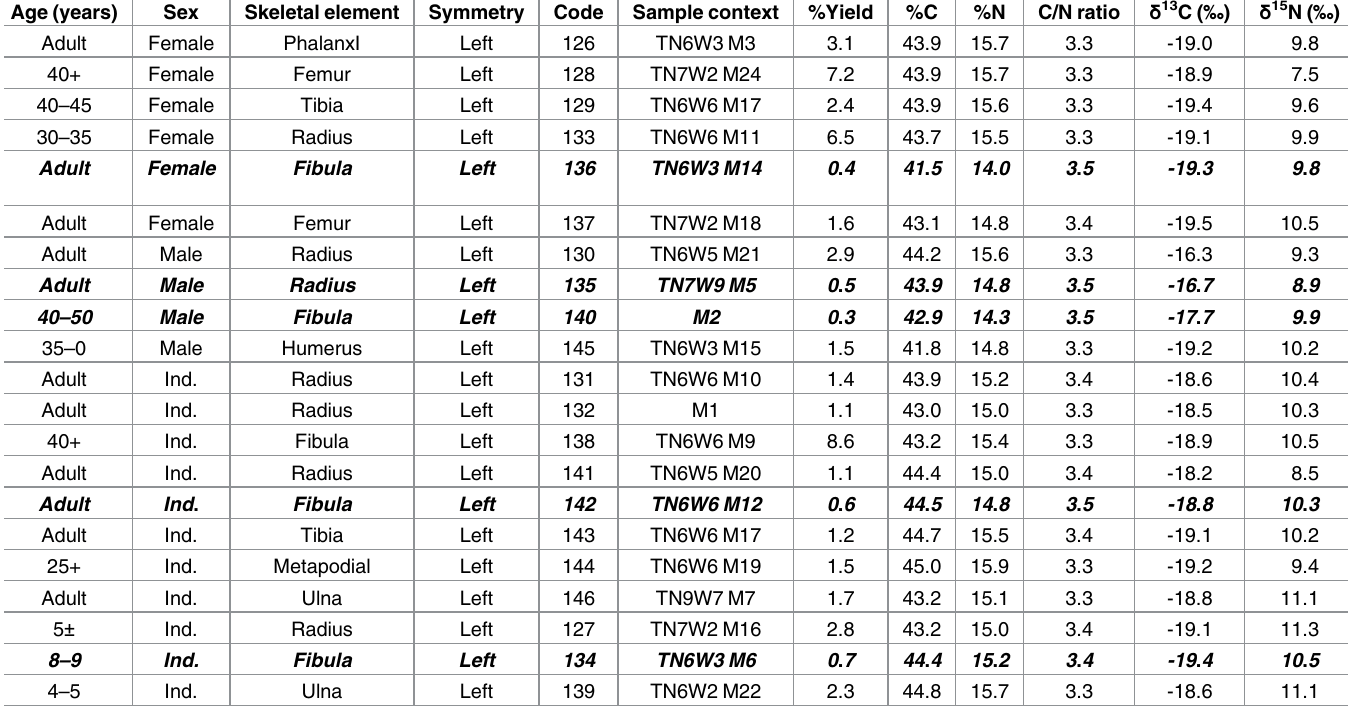
Table 2. Isotopic composition and quality indicators of human samples from Shilinggang, Yunnan. The samples marked in bold italics were found to be contaminated, and were not includedin further statistical analysis. Context locationsare shown in Fig 2a. Among the sample context codes, TNnWn (where n is an Arabic numeral)refers to excavation unit; Mn (wheren is an Arabic numeral) refers to the grave number. “Ind.” stands for